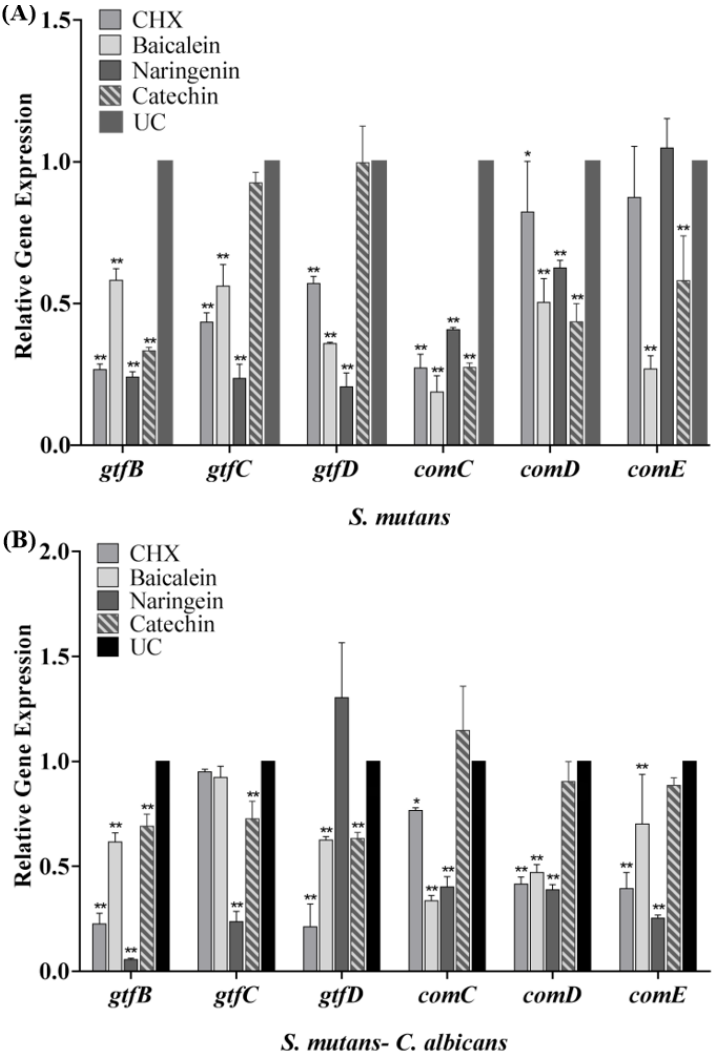
Figure 6. The S. mutans gtfB / C / D , comC / D / E gene expression in single-species ( A ) and dual-species biofilms ( B ) via qRT-PCR (mean ± sd, n = 3; * p < 0.05, ** p < 0.01).